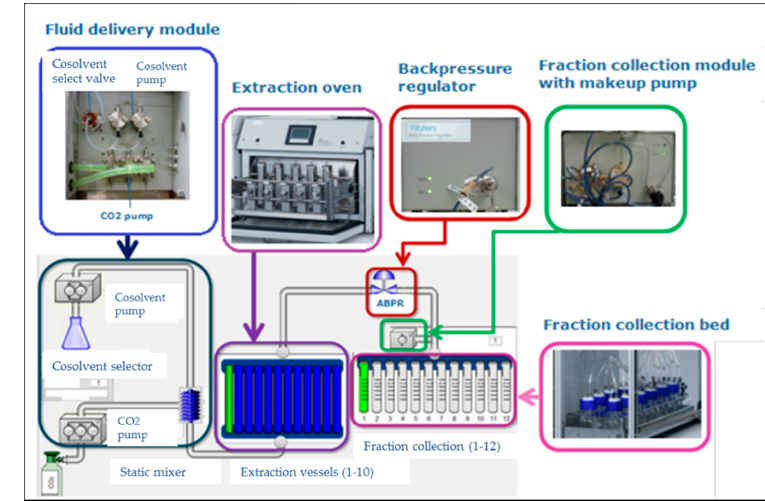
Figure 8. The external appearance and the component diagram of a Waters ASFE MV-10 extractor (Source: author’s photo; diagram MV-10 ASFE System Guide for ChromScope IE v1.20).